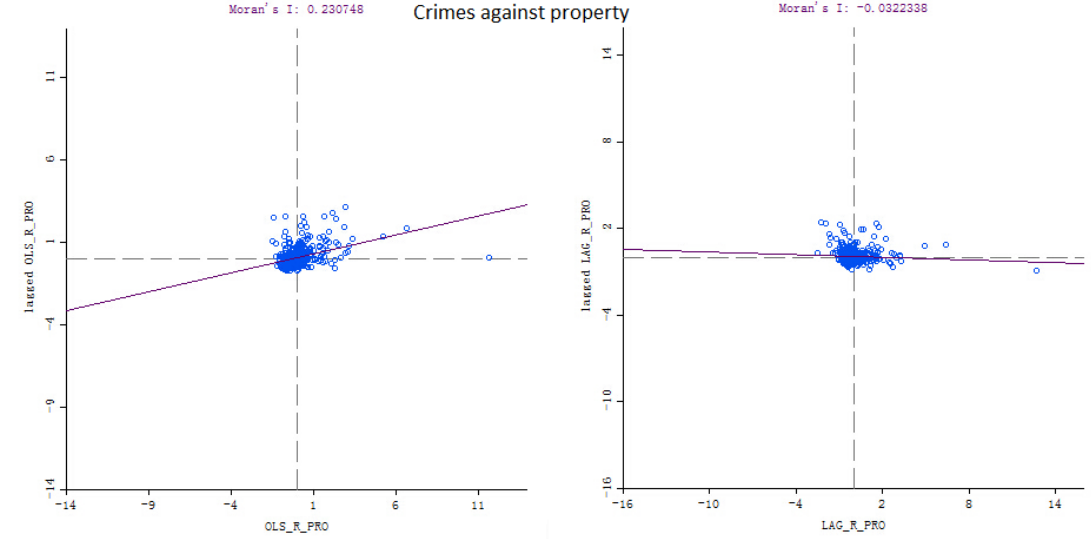
Figure 4. Moran’s I tests for crimes against property (OLS: left; Spatial lag: right).